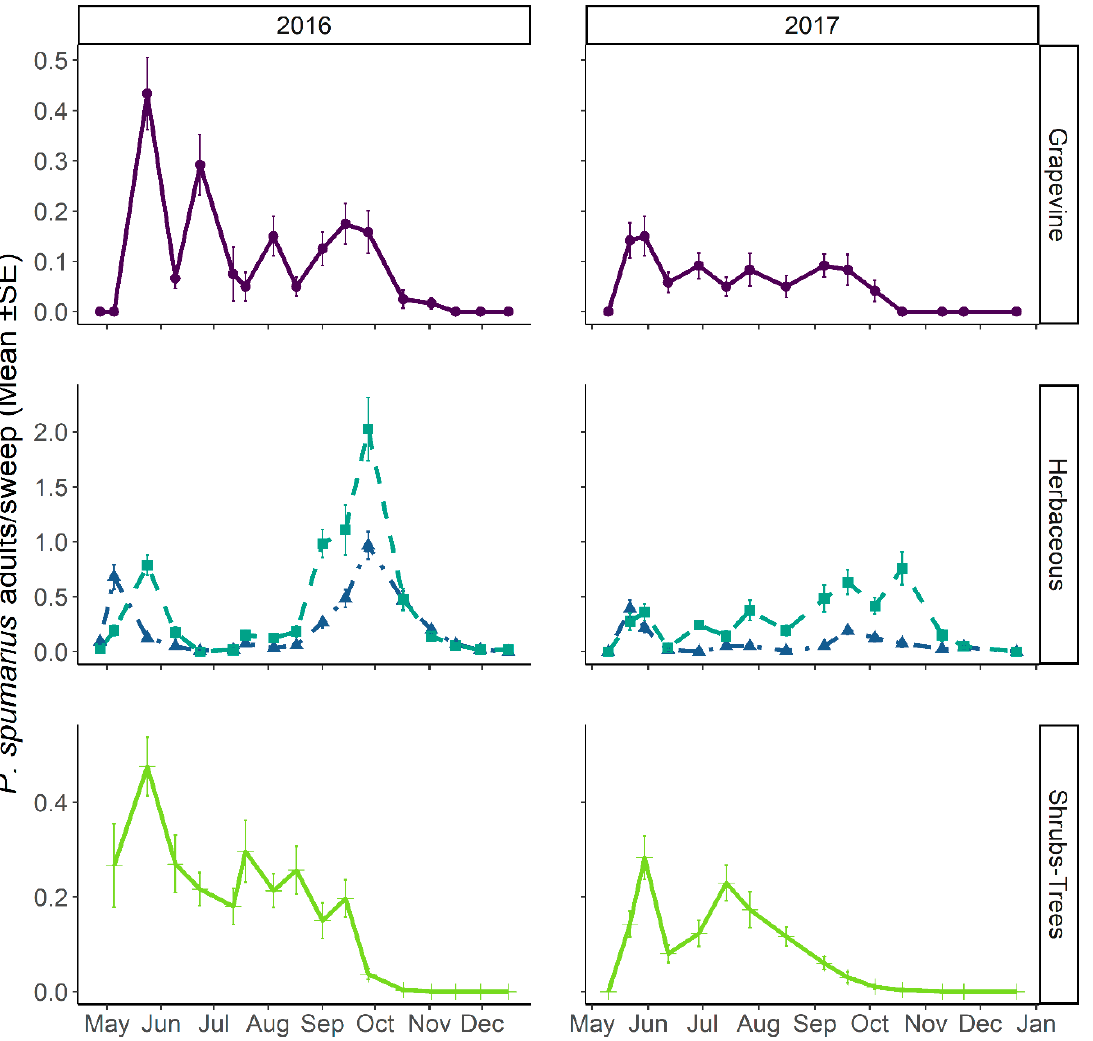
Figure 8. The abundance of Philaenus spumarius adults on grapevine ( top ), herbaceous cover ( middle ), and shrub–tree ( bottom ) components in the Asti vineyard throughout 2016 ( left ) and 2017 ( right ) sampling periods. In herbaceous vegetation, dashed lines represent headlands and dash-dotted lines represent inter-rows.